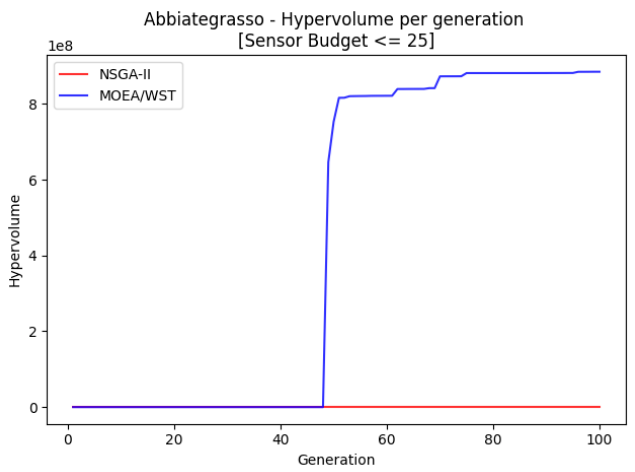
Figure 17. Hypervolume per generation.